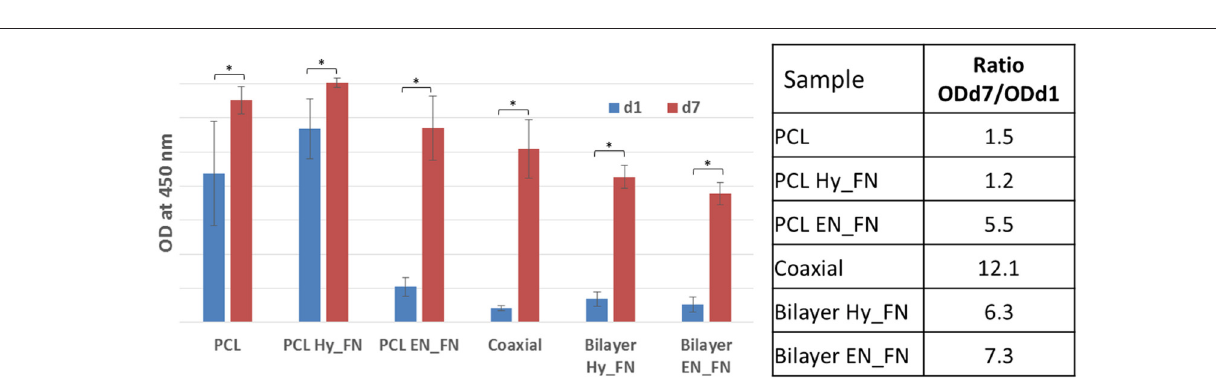
pivotal to understand the relevance of the graded scaffolds in terms of morphology and functionalization for supporting cell